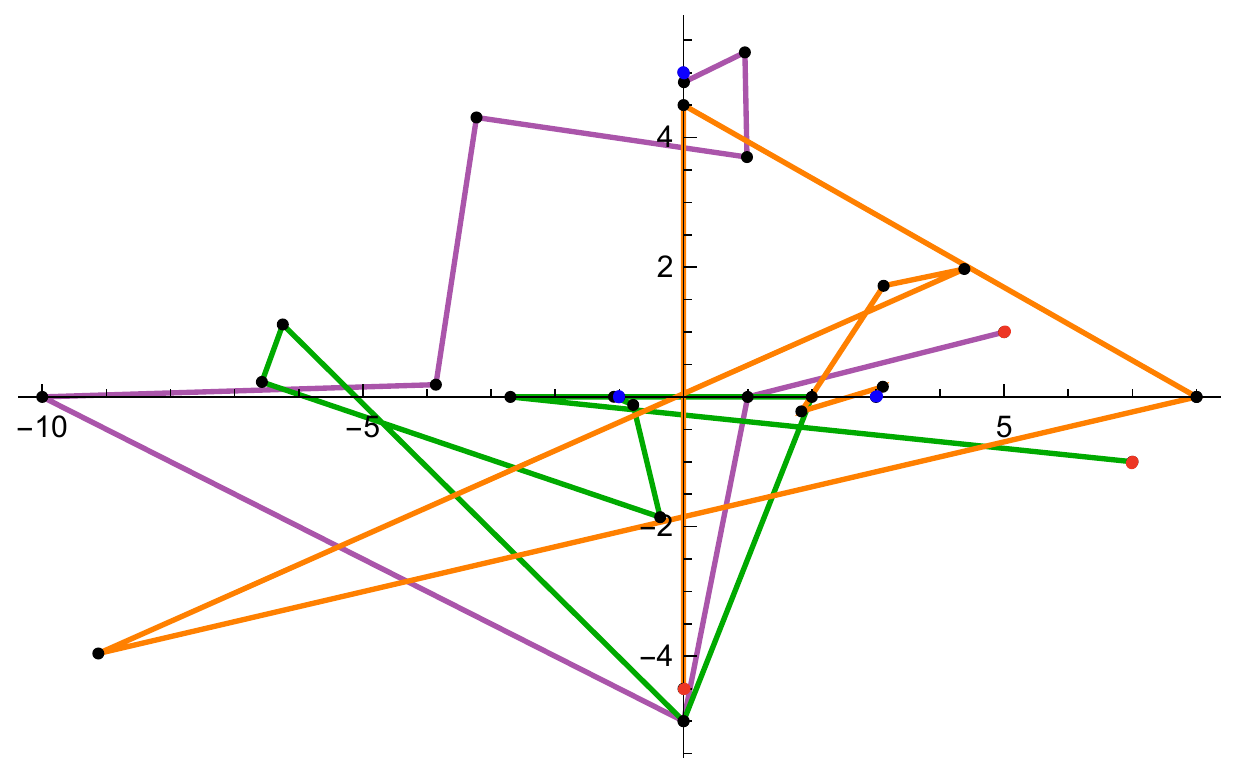
Figure 1. Trajectories of the approximations for Example 1 ( N = 3).